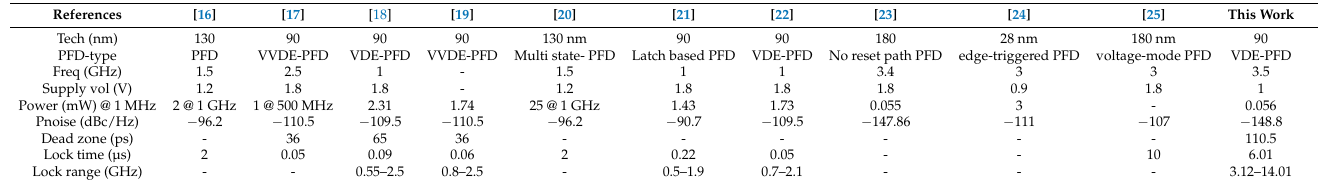
Table 3. Overview of novel CP-PLL